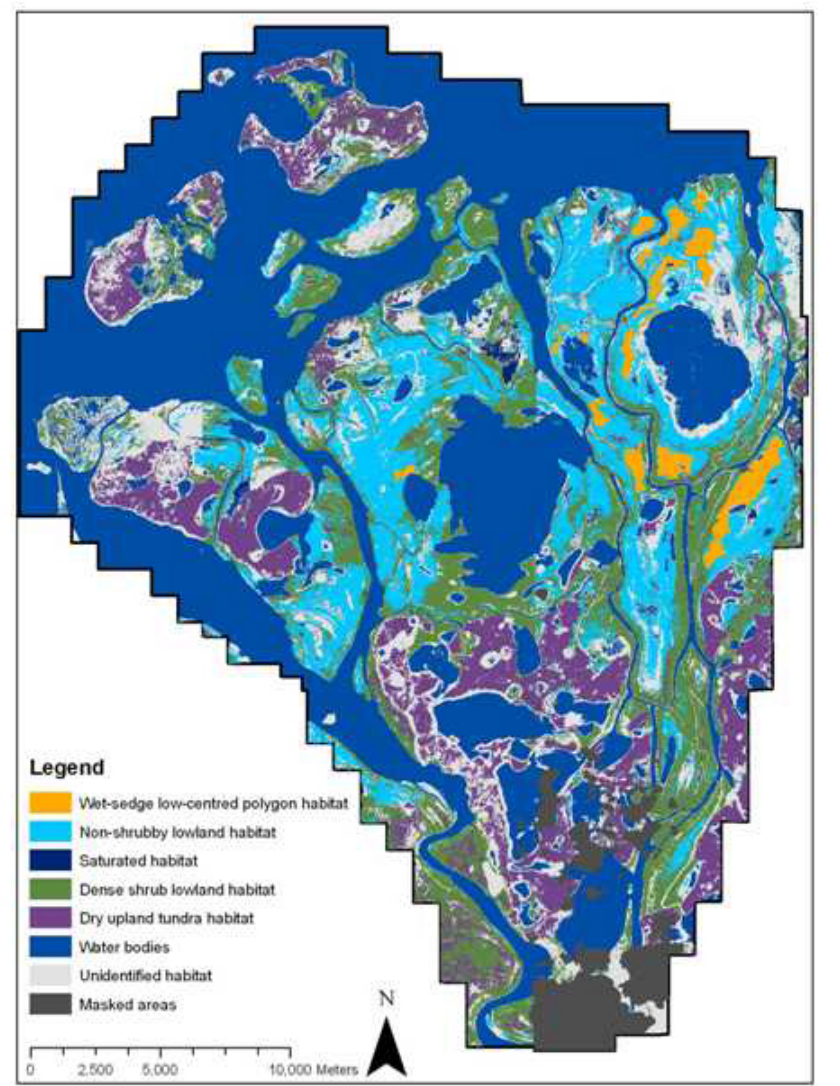
Fig. 6. Land-cover map of the Kendall Island Bird Sanctuary and Fish Island in the outer Mackenzie Delta, Northwest Territories showing four land-cover classes derived from a supervised classification of Ikonos imagery, as well as areas that were unidentified in the classification, water bodies, and areas that were masked out of the imagery before classification. In addition, areas of wet-sedge low-centered polygon habitat were distinguished from within the non-shrubby lowland habitat by visual pattern analysis of the